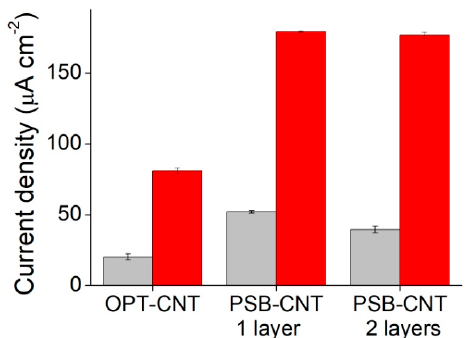
Figure 4. Performance of different HRP enzymatic electrodes. Bars shows the values of current density measured at 60 s at an applied potential of − 0.280 V in a PBS buffer containing 4 mM hydroquinone in the absence of H 2 O 2 (grey) and with the addition of 1.5 mM H 2 O 2 (red) for oxygen plasma-treated CNT-ink-printed electrodes (OPT-CNT), and carbon SPE coated with one and two layers of PBS-modified CNT ink (PSB-CNT).